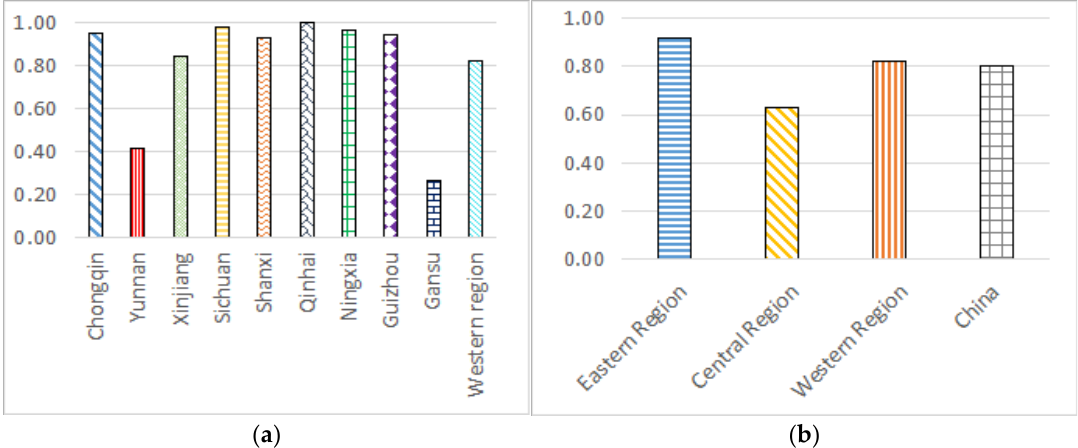
Figure 4. ( a ) Average value of western region provinces; ( b ) Average value of China and regions.